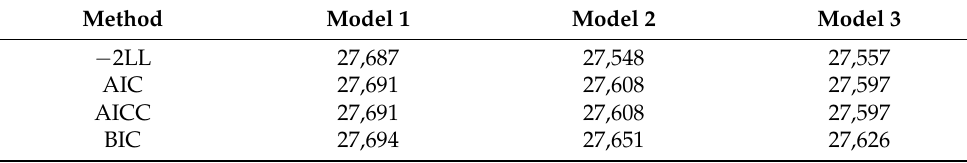
Table A2. Model fitting